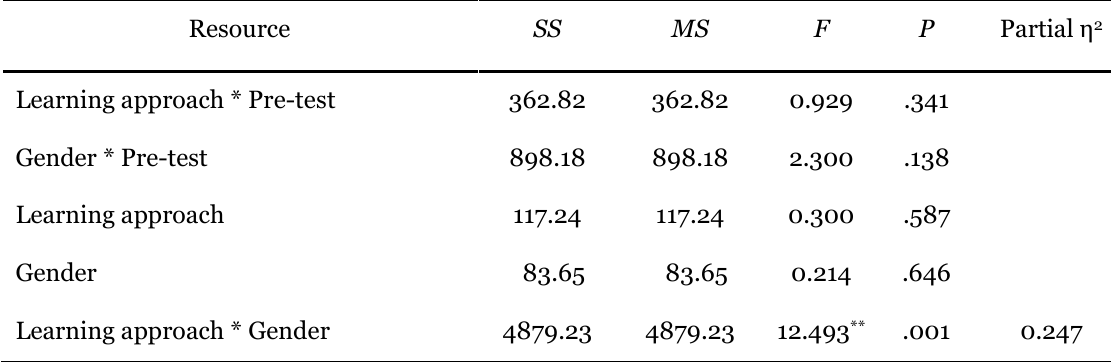
Two-Way ANCOVA Tests of Between-Subjects Effects Resource